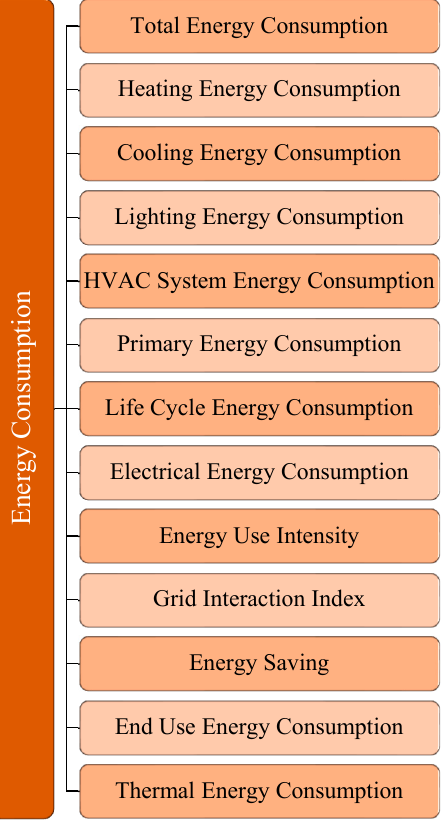
Energies 2021 , 14 , x FOR PEER REVIEW Figure 5. Energy consumption indicators. Figure 5. Energy consumption indicators.